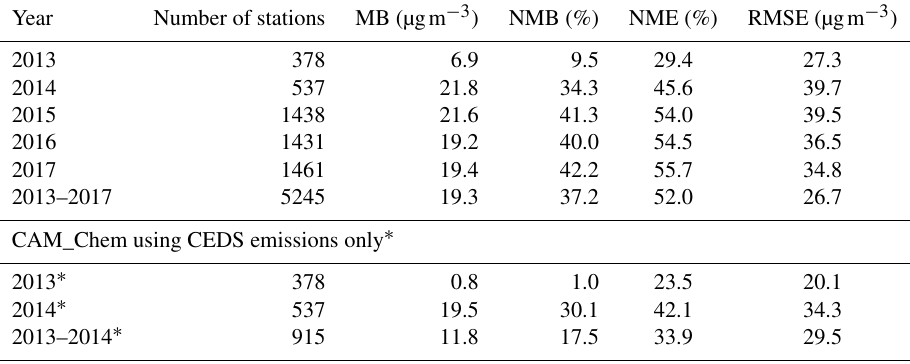
Table 2. Model performance for the annual PM 2 . 5 concentration compared with surface observation in China from 2013 to 2017, with mean bias (MB, µgm − 3 ), normalized mean bias (NMB, %), normalized mean error (NME, %), and root-mean-square error (RMSE, µgm − 3 ).